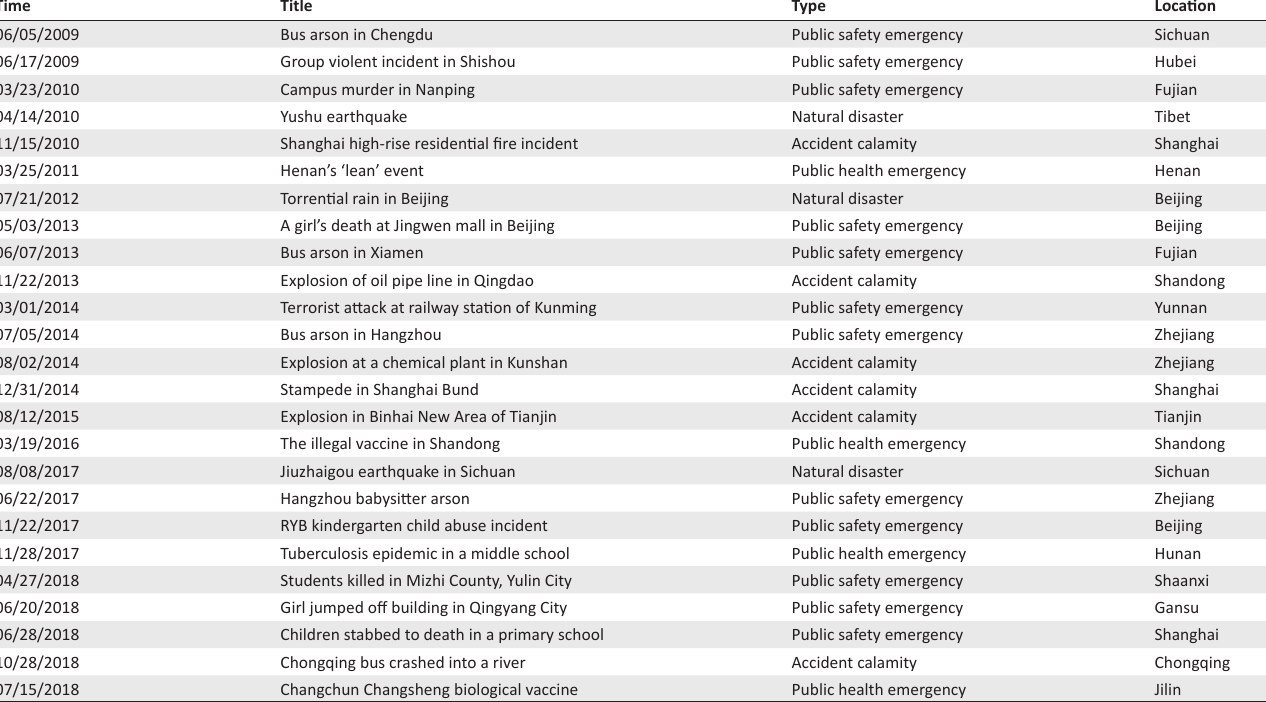
TABLE 2: List of 25 major emergencies over the past decade in China.